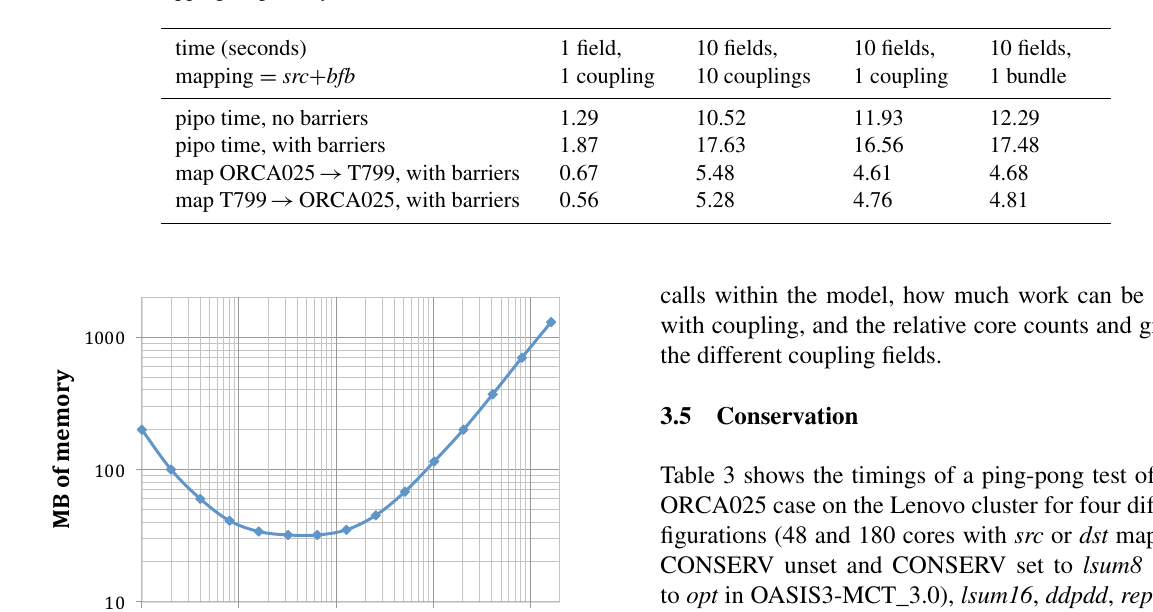
Table 2. Comparison of unbarriered and barriered ping-pongs (pipo) and barriered mapping time for the T799-ORCA025 toy model on Lenovo on 180 cores per component for coupling of 1 field, coupling of 10 fields one at a time, coupling of 10 fields using OASIS3-MCT multiple-coupling-field capability, and coupling of 10 fields by a single 3-D bundle. All times are for src + bfb mapping for 1000 ping-pongs. For barriered times, MPI barriers were introduced in both components before the send and before the mapping to force serialization of work and to time the mappings separately.